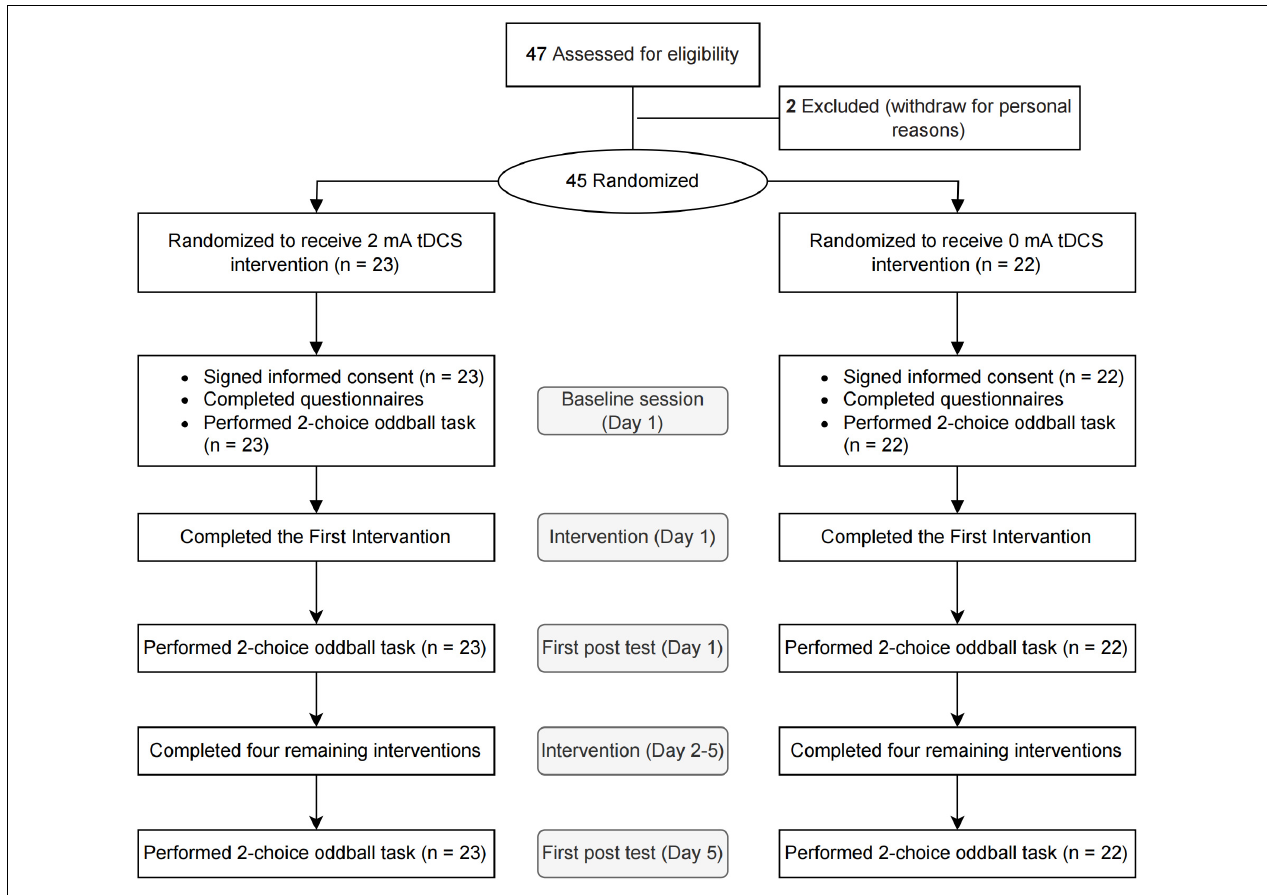
FIGURE 1 | Flow-chart of the experimental